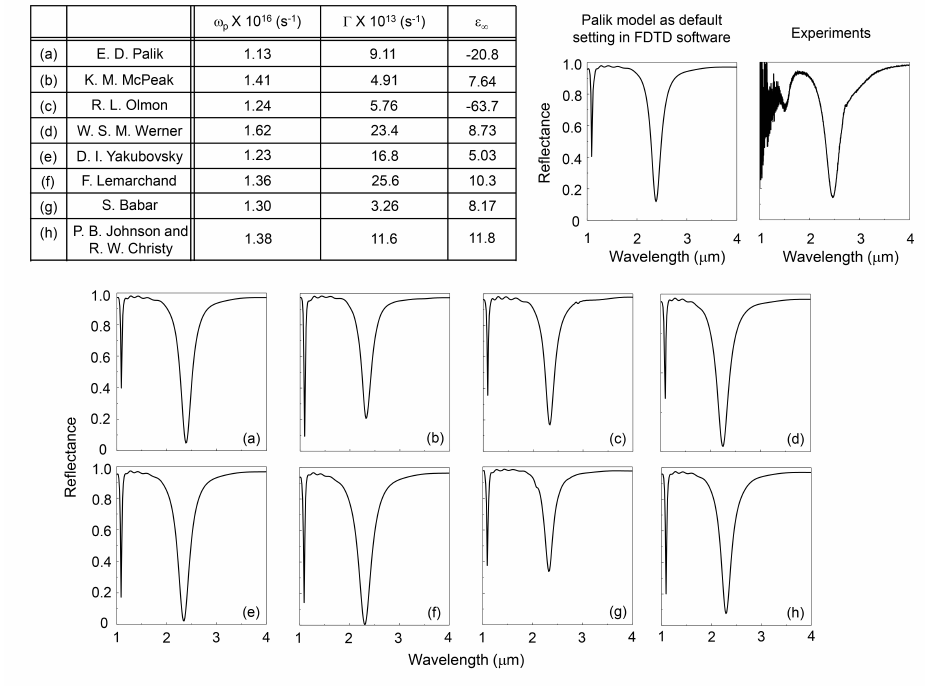
Figure 4. Drude parameters of the permittivity of Au were obtained from the references listed below. The parameters of D = 600 nm , P = 1200 nm, t i = 50 nm were used: ( a ) Palik [15], ( b ) McPeak [18], ( c ) Olmon [19], ( d ) Werner [20], ( e ) Yakubovsky [21], ( f ) Lemarchand [22], ( g ) Babar [23] and ( h ) Johnson and Christy [16]. The FDTD simulation results by (a) Palik parameters from the FDTD Lumerical software database (a default) were used for the Drude model calculations (see table). Also, the experimental reflection spectrum is shown.